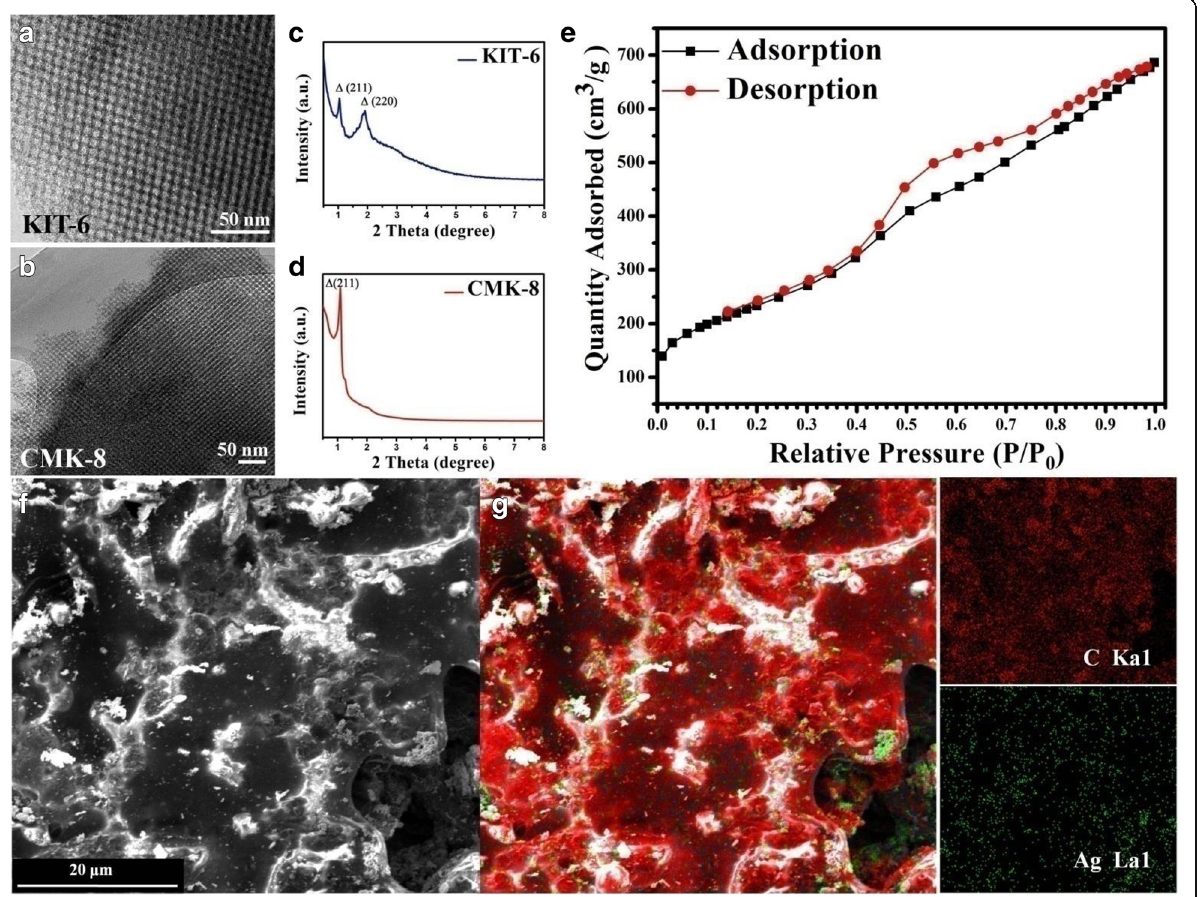
Fig. 1 Characterization of KIT-6 and corresponding CMK-8. a , b High-magnification TEM images. c , d Small-angle XRD patterns. e N 2 adsorption/ desorption isotherms (77 K) of CMK-8. f , g SEM image and corresponding EDX elemental mappings of C, Ag, and Ag/CMK-8-Nafion